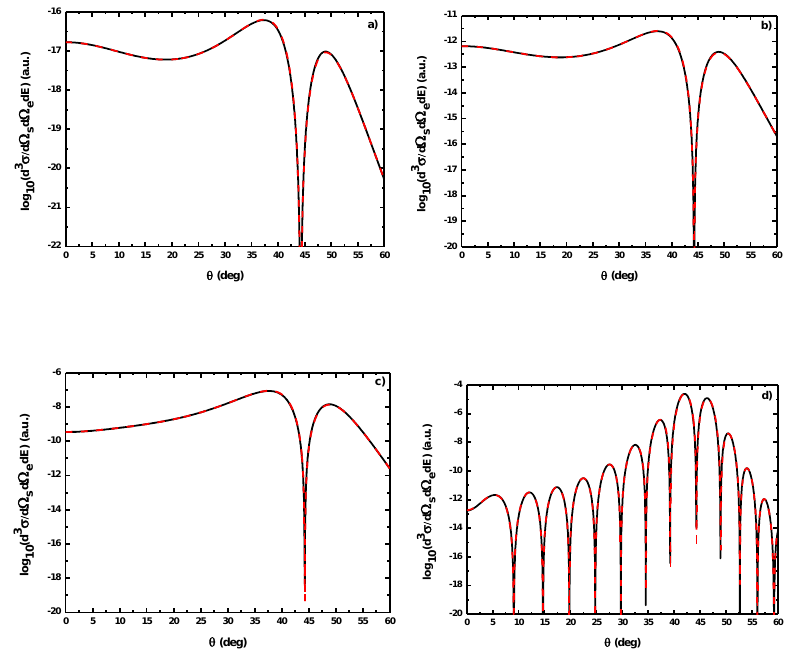
Figure 20. (Color online) All the parameters are the same as Figure 19, but with the absorption of one photon ( (cid:96) = 1 )